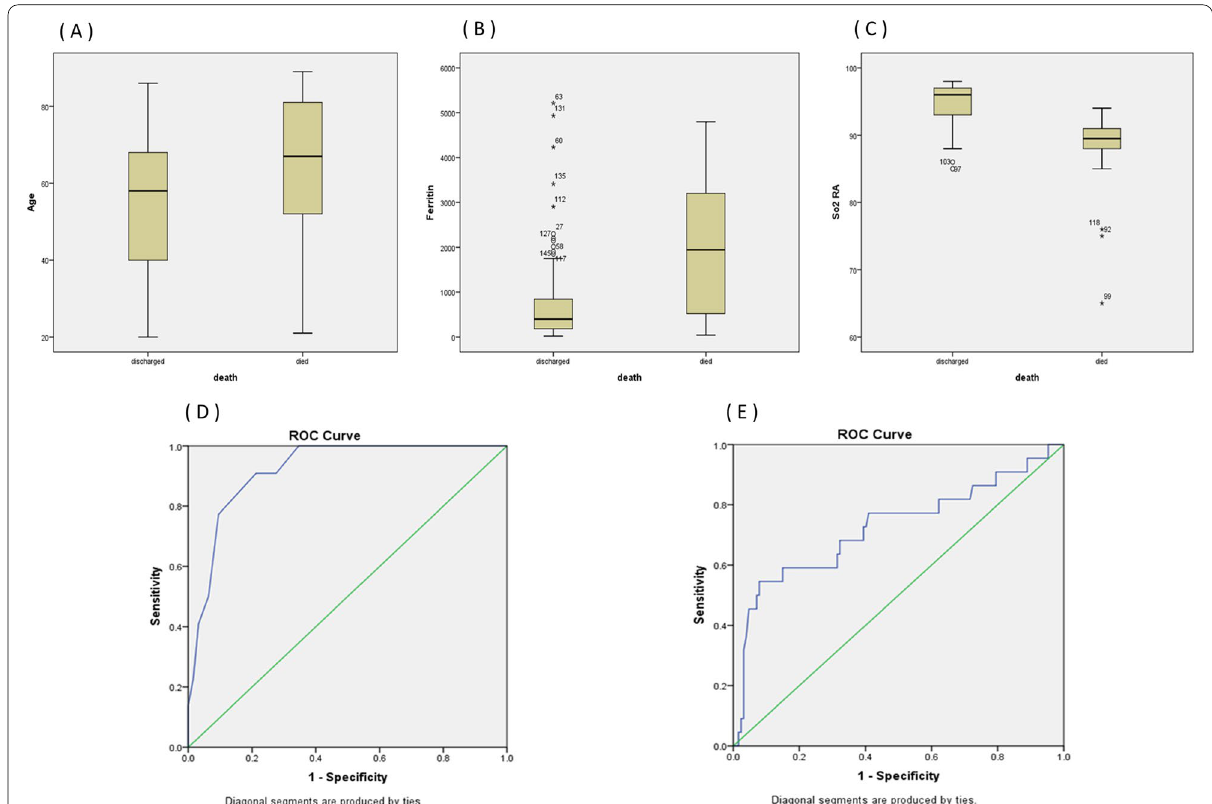
Fig. 2 A Boxplot for Age Distribution in relation to mortality. B Boxplot for serum ferritin distribution in relation to mortality. C Boxplot for baseline oxygen saturation distribution in relation to mortality. D Receiver operator characteristics (ROC) curve for baseline oxygen saturation in non-surviving patients. E Receiver operator characteristics curve for serum ferritin in in non-surviving